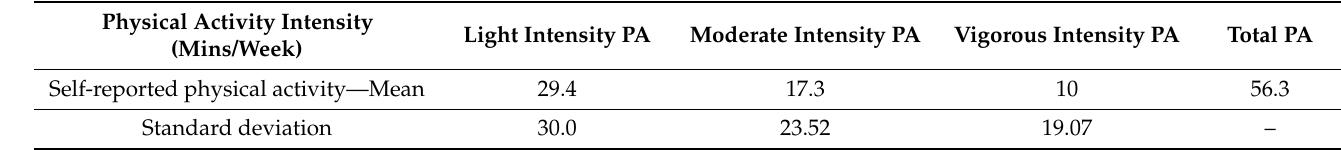
Table 2. Descriptive statistics of physical activity levels among working adults.